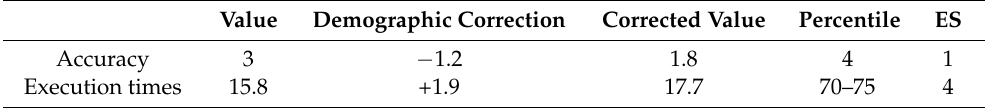
Table 16. Example 2 of application of GVT in one case: scoring. Value Demographic Correction Corrected Value Percentile ES Accuracy Execution